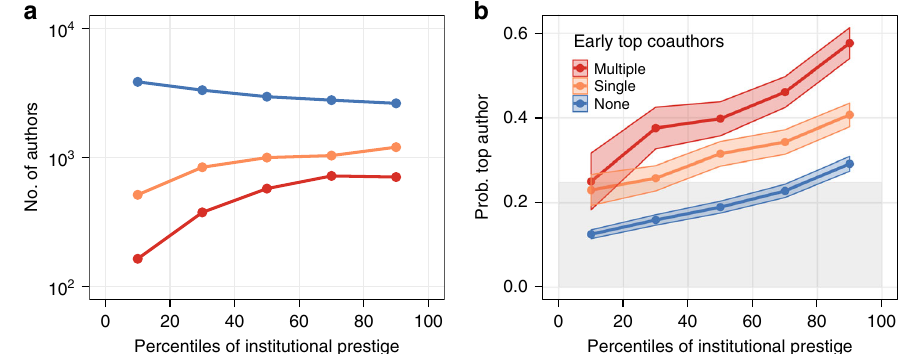
Fig. 1 Relationship between early career institutional prestige and probability of becoming a top scientist. a Number of junior researchers in each quintile of the distribution of institutional prestige. b Probability of being a top scientist in the 20th career year as a function of institutional prestige (ribbon bands denote 95% con fi dence intervals). In both panels authors are grouped based on whether in their fi rst 3 career years they coauthored papers with one (orange), multiple (red), or no (blue) top scientists. The grey shaded area in b represents the unconditional probability of becoming a top scientist for